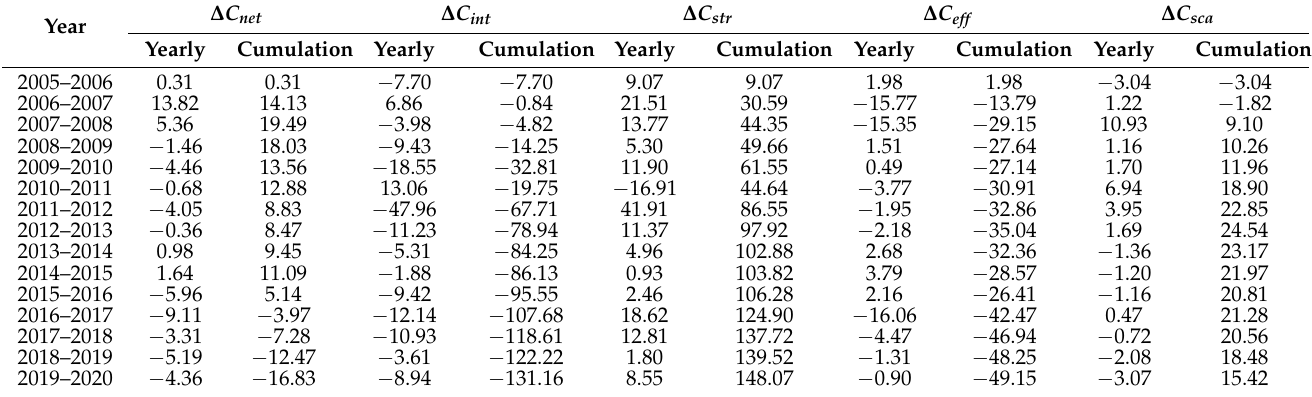
Table 5. LMDI decomposition results in net carbon emissions from marine fisheries in China (10 5